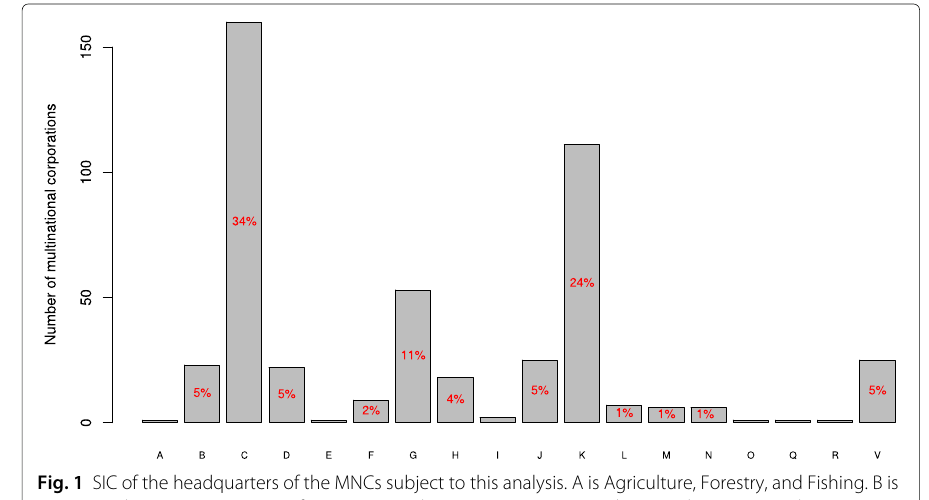
Fig. 1 SIC of the headquarters of the MNCs subject to this analysis. A is Agriculture, Forestry, and Fishing. B is Mining and Quarrying. C is Manufacturing. D is Electricity, Gas, steam, and Air conditioning supply. E is Water supply, Sewerage, Waste management, and Remediation activities. F is Construction. G is Wholesale and Retail trade, and Repair of motor vehicles and motorcycles. H is Transportation and Storage. I is Accommodation and Food service activities. J is Information and Communication. K is Financial and Insurance activities. L is Real estate activities. M is Professional, Scientific, and Technical activities. N is Administrative and Support service activities. O is Public administration and Defense, and Compulsory social security. Q is Human health and Social work activities. R is Arts, Entertainment, and Recreation. V is no information in the dataset